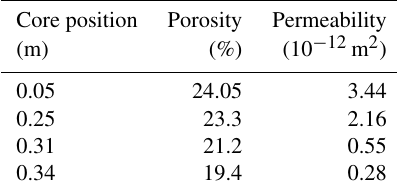
Table 1. Porosities and permeabilities along a 0.5m Bentheim core observed during a core flooding experiment (Bartels et al., 2002). Core position Porosity Permeability (m) (%) (10 − 12 m 2 ) 0.05 24.05